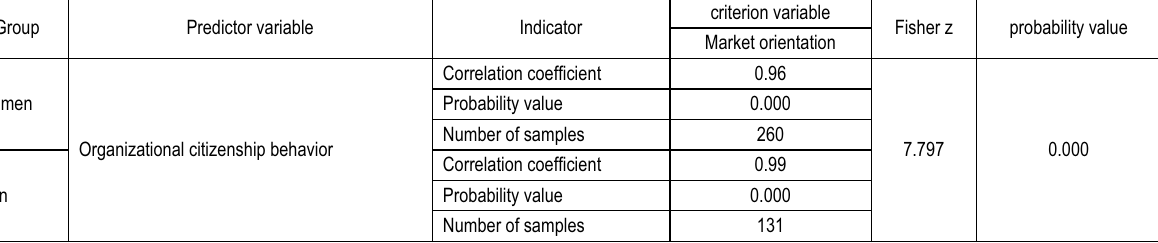
Table 7. Relationship between organizational citizenship behavior and market orientation in terms of gender Group Predictor variable